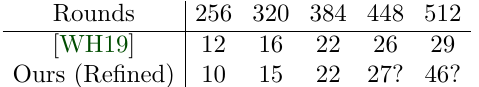
Table 13: Score of the best linear trail with unrestricted input, restricted output found for number of rounds evaluated by the original submission document. Question mark (?) signifies that the solver did not